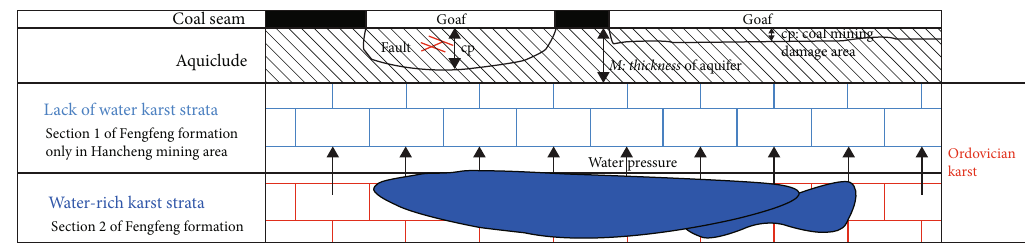
Figure 2: Schematic diagram of water inrush from coal mining fl oor.